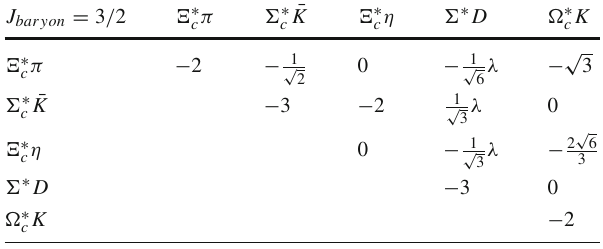
Fig. 2 Diagram of L → H vertex with V H emission, where L is a light meson, H a heavy meson and V H a heavy vector